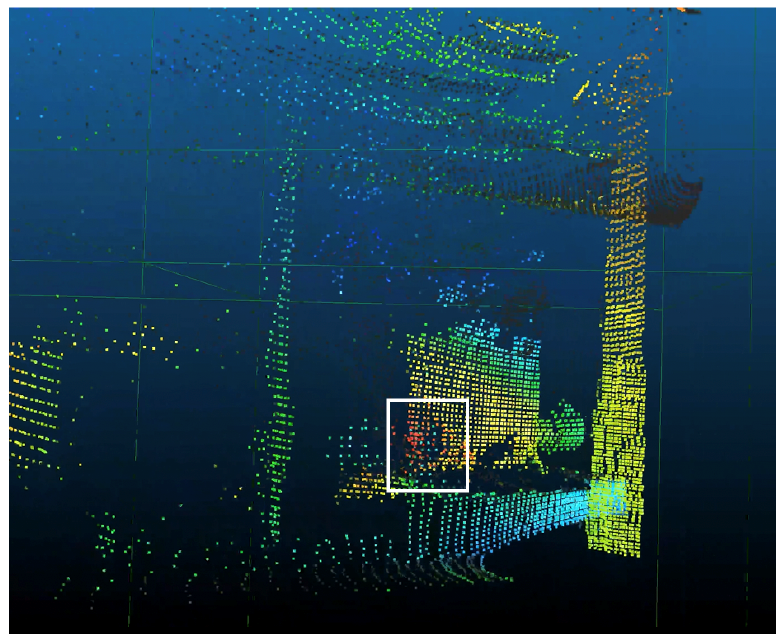
Figure 6. 3D radiation intensity (colour-map) point-cloud of an internal space exhibiting vertical faces representative of walls. A region with elevated activity at the centre of the scan is identified— representing an accumulation of radioactive material. Even without visible image overlay, a high density point cloud enables observers to identify object contours with ease. In this scan, the pixel overlap is approx. 700%, causing a spatial averaging effect equivalent to a Gaussian blur. In this scan, the frame projection is ca. 0.8m tall and 0.6m wide at a distance of ca.